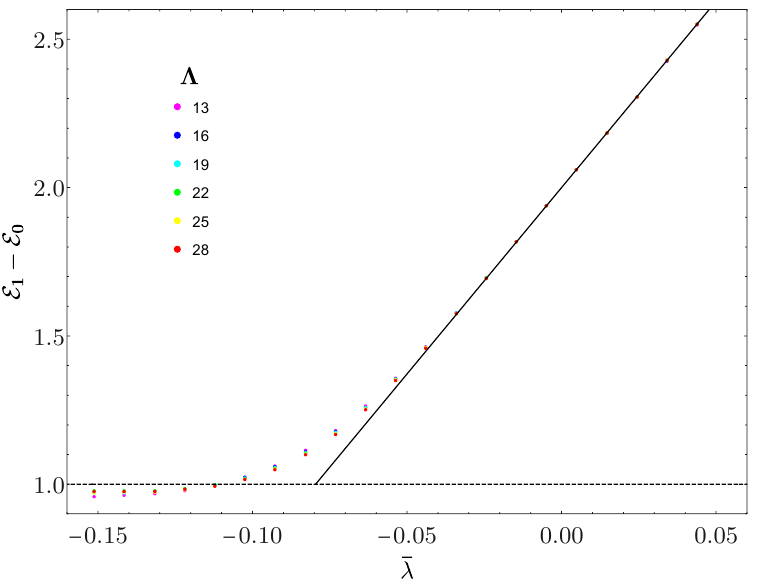
Figure 25. Energy of the first excited state in the Ising model with thermal deformation, in a range of couplings including ¯ λ < 0 . The solid line is the exact solution. Notice that in this model ¯ ¯ λ = R , hence this plot is the continuation of the plot in figure 23. We use the label with the other examples.